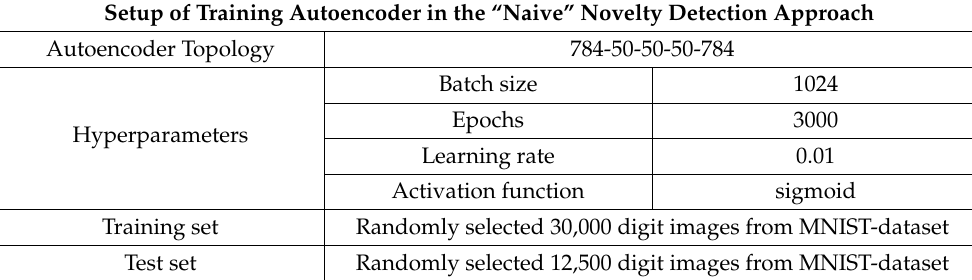
mented as ROS2 [33] nodes and serve as part of the quantitative monitor (cf. Figure 3). Table 1. Training setup of the autoencoder in the “naive” novelty detection. Setup of Training Autoencoder in the “Naive” Novelty Detection Approach Autoencoder Topology